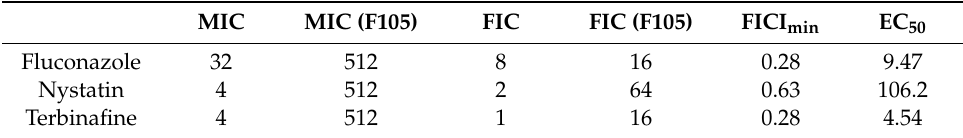
Table 2. Minimum inhibitory concentration (MIC), fractional inhibitory concentration (FIC), FICI,